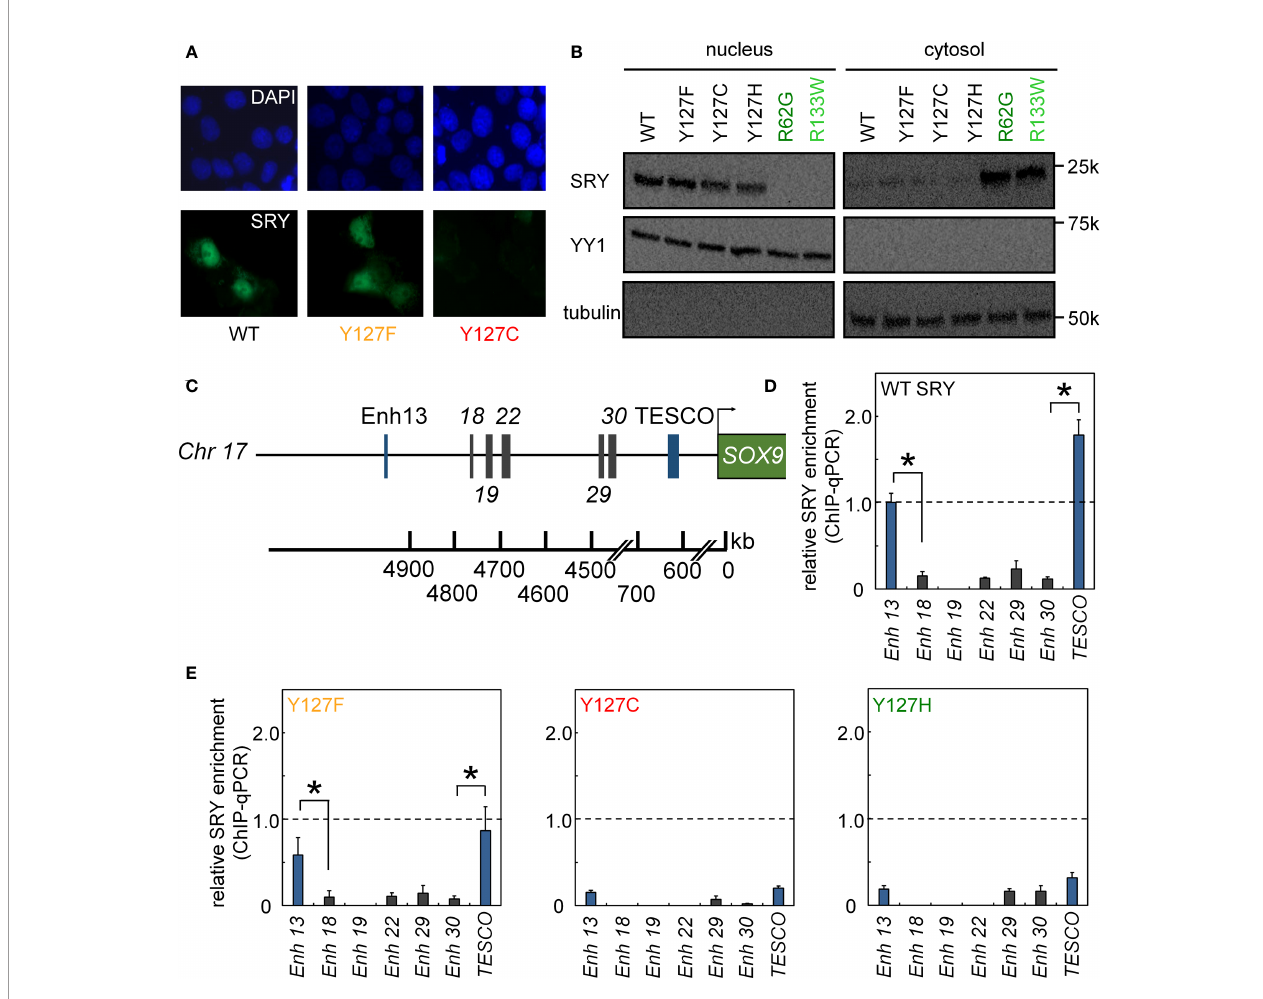
FIGURE 4 | Nuclear localization and gene-regulatory activities of SRY variants. (A) Subcellular localization of epitope-tagged SRY constructs as analyzed by immunostaining (30): DAPI nuclear staining (upper row blue) and SRY (lower row green). WT and Y127F SRY accumulate primarily in nuclei but with underlying pancellular pattern (30). Y127C SRY exhibited decreased accumulation (see Figure 6 ). (B) Biochemical fractionation of SRY variants was analyzed by immunoblotting in cytoplasmic or nuclear fractions (30). Controls were provided by clinical variants R62G (defective N-NLS) R133W and R133W (defective C-NLS), as shown in dark- and light green, respectively. (C – E) Speci fi c enhanceosome formation is perturbed by mutations. (C) Sox9 / SOX9 enhancers containing potential SRY binding motif are outlined in schematic form; code follows ref (17); DNA sequences are given as Supplemental Information . (D, E) ChIP-qPCR results delineate distribution of relative SRY occupancies as regulated by either WT SRY (D) and variants Y127F, Y127C, and Y127H (E) . Statistical signi fi cance at the level p<0.05 (Wilcox test) for SRY-dependent transcriptional activation